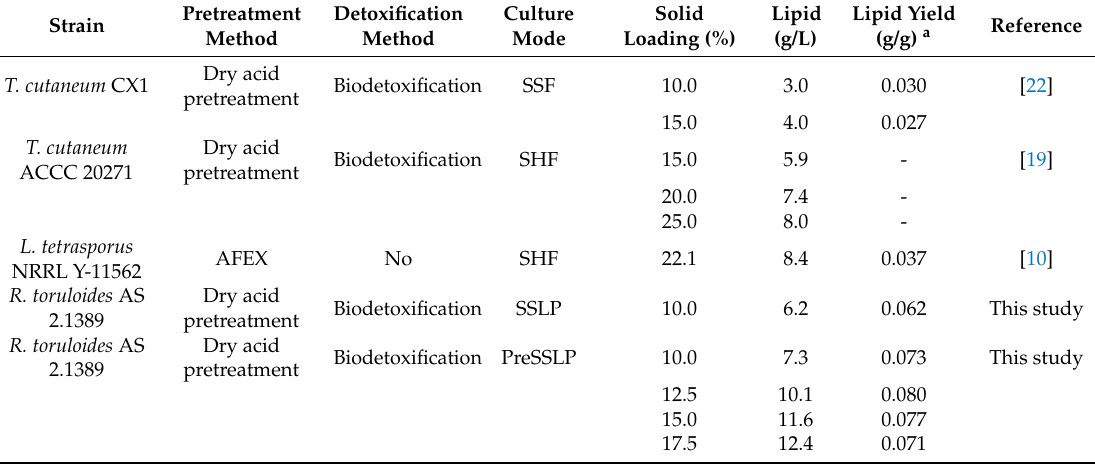
Table 4. Lipid production from corn stover by different approaches.